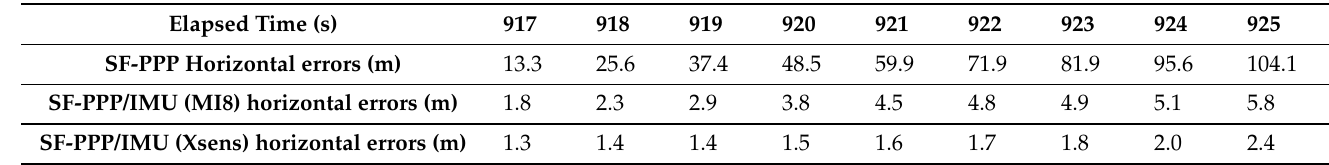
Table 4. Horizontal errors growth with different sensor fusion combinations for single-frequency PPP over Outage B.